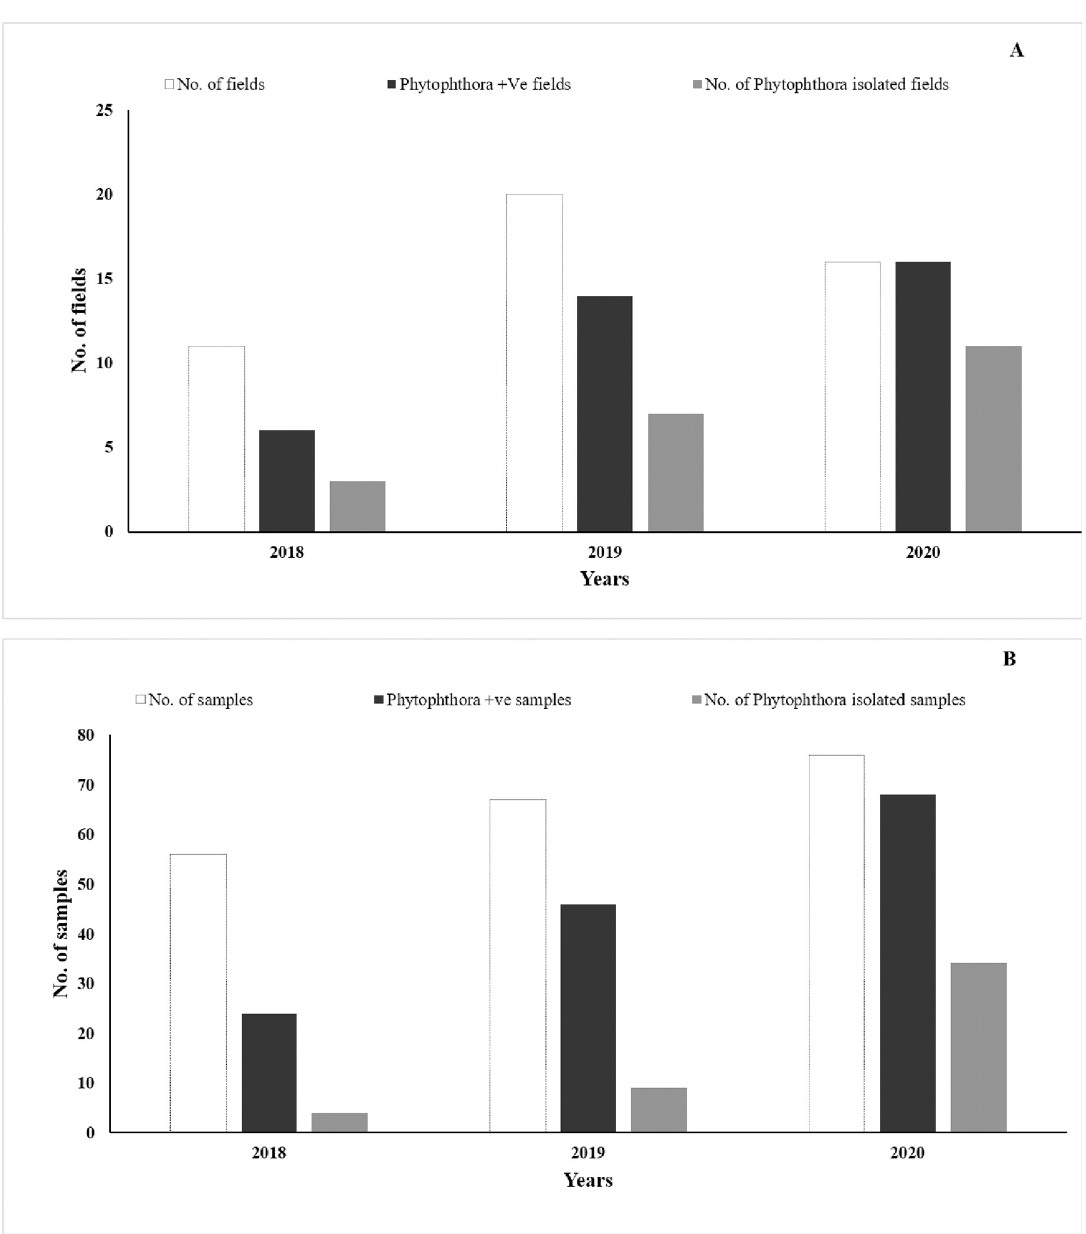
Fig 4. Numbers of Phytophthora positive and Phytophthora isolated fields (A) and samples (B). Phytophthora positive fields were confirmed with Agdia ImmunoStrip assay and species of Phytophthora were identified using HiPlex targeted-sequencing approach.